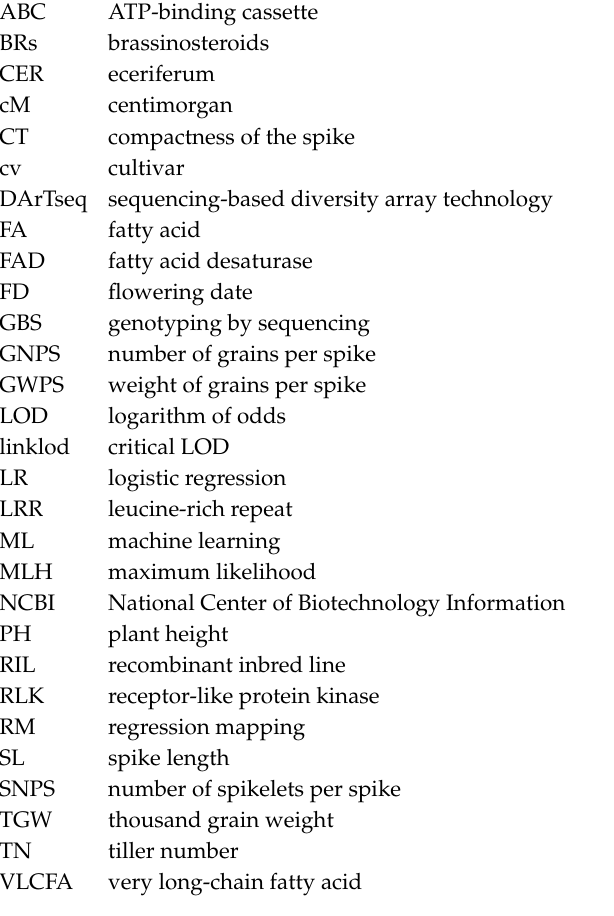
Table S1: Segregations of DARTseqs in rye mapping population BK2, assigned to 2R based on literature; Table S2: Segregations of DARTseqs in rye mapping population BK2, not assigned to chromosomes based on literature; Table S3: Segregations of DARTseqs in rye mapping population BK2, selected to map 2R; Table S4: The reference map of chromosome 2R of rye RIL-S population [56]; Table S5: Map of 2R of rye BK2 population constructed of 883 loci linked to wax at LOD 50 using maximum likelihood algorithm; Table S6: Loci connected with wax segregation, selected based on three machine learning methods; Table S7: Wax locus region map constructed using 31 loci (17 nearest flanking loci from whole BK2 map and selected 13 loci pointed out in three machine learning methods) using a regression mapping algorithm; Table S8: Meteorological data for the years of conducting experiments at the field of the West Pomeranian University of Technology in Szczecin